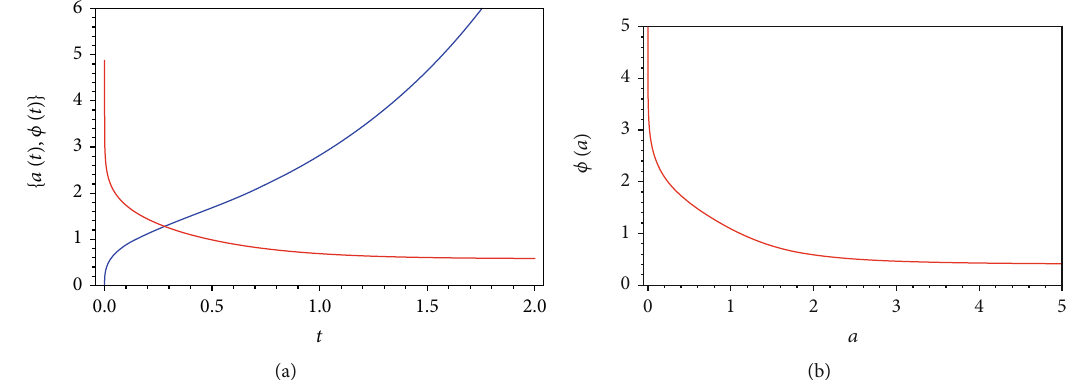
Figure 1: (a) The qualitative dynamical behavior of the scale factor (blue line) and scalar fi eld (red line) in the fl at universe. (b) Classical trajectory in the plane a − ϕ . The fi gures are plotted for numerical values: g Λ = 1 , C = 5 , λ = 1 , m = 2 , and ϕ